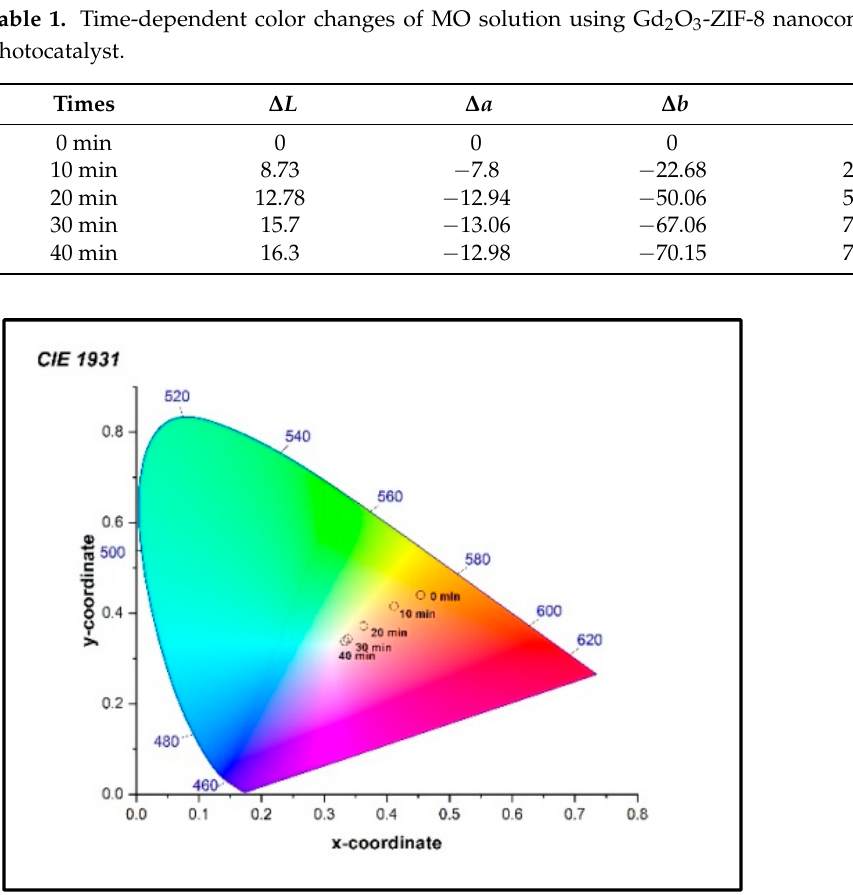
Table 1. Time-dependent color changes of MO solution using Gd tocatalyst.